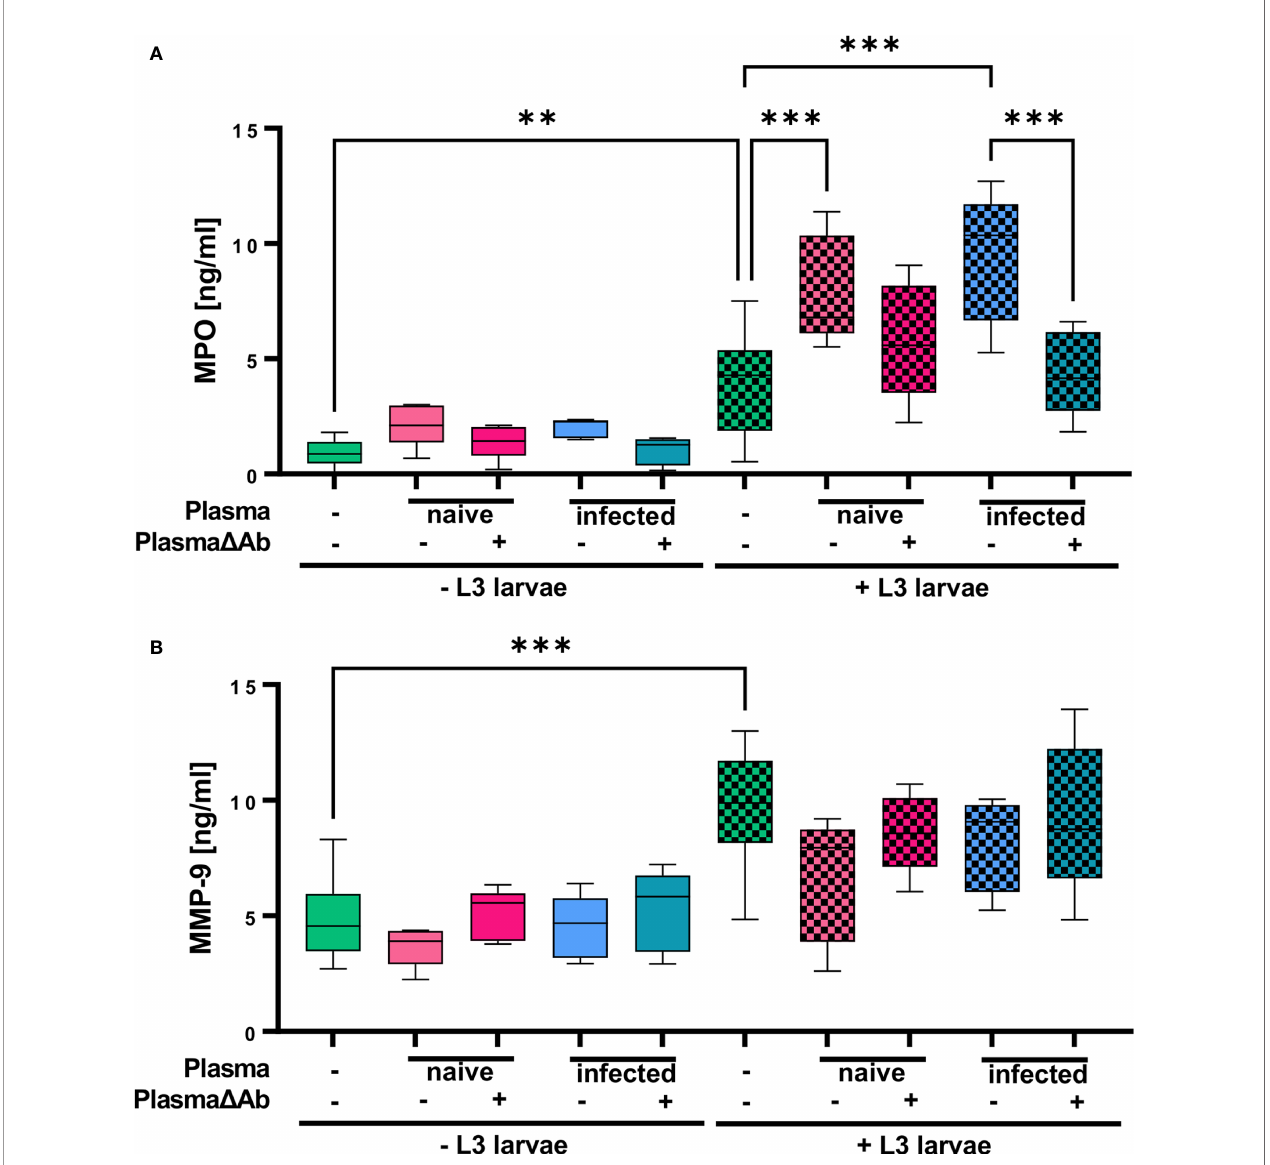
FIGURE 6 | S. ratti L3 induce release of MPO and MMP-9-containing granules. (A) MPO and (B) MMP-9 concentration measured in the supernatant of neutrophils stimulated with plasma from S. ratti -infected or naive animals, S. ratti L3 larvae alone or in combination with plasma. Plasma has been left untreated or antibody- depleted ( D Ab). Shown are box plots with tukey with n=5. One out of two independent experiment. One-Way ANOVA with Bonferroni post-hoc test. Only statistically signi fi cant comparisons are depicted, all other comparisons were statistically not signi fi cant. p < 0.01 **, p < 0.001